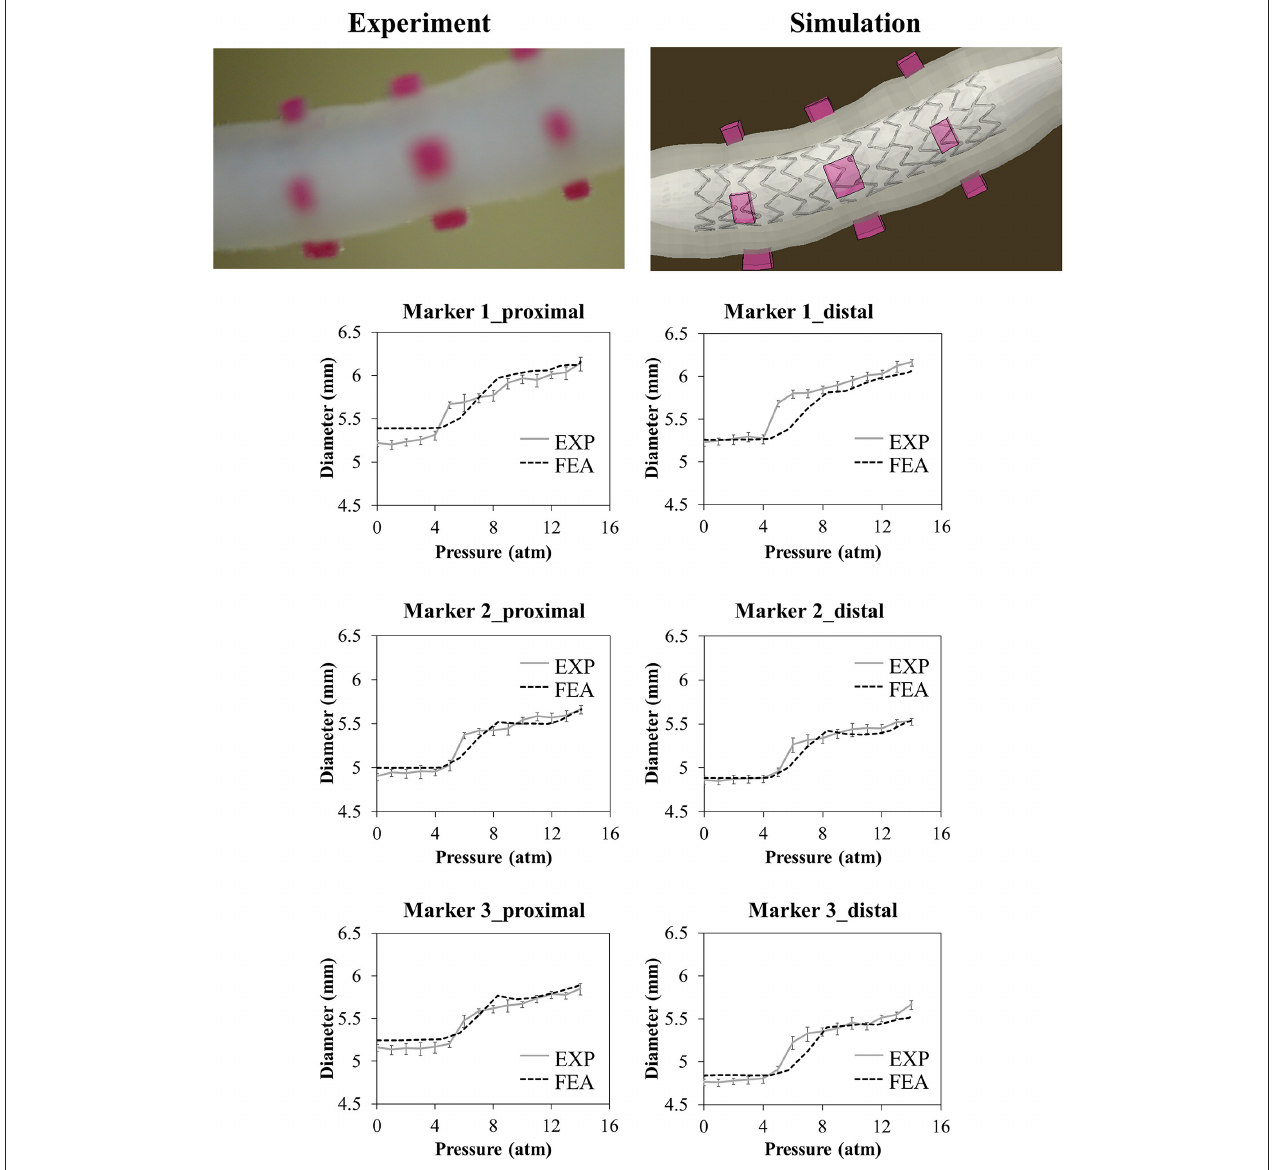
FIGURE 9 | Comparison between experimental and numerical results of the deployment of the SYNERGY TM in a realistic vessel, taken at Marker 1,2,3 (from proximal to distal). Only data regarding the loading phase are reported due to the vessel rupture at deflation. A qualitative comparison between experimental and numerical configuration is reported considering the final instant of the balloon deflation